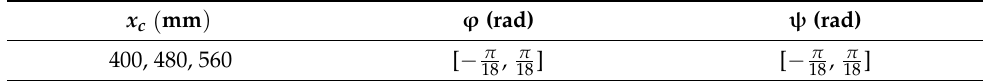
Table 5. The positional posture parameters.